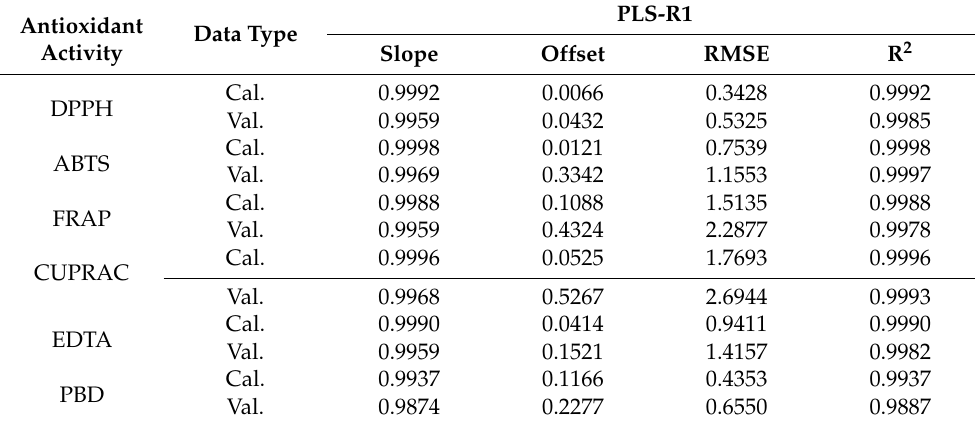
Table 4. PLS-R1 model parameters used for prediction.